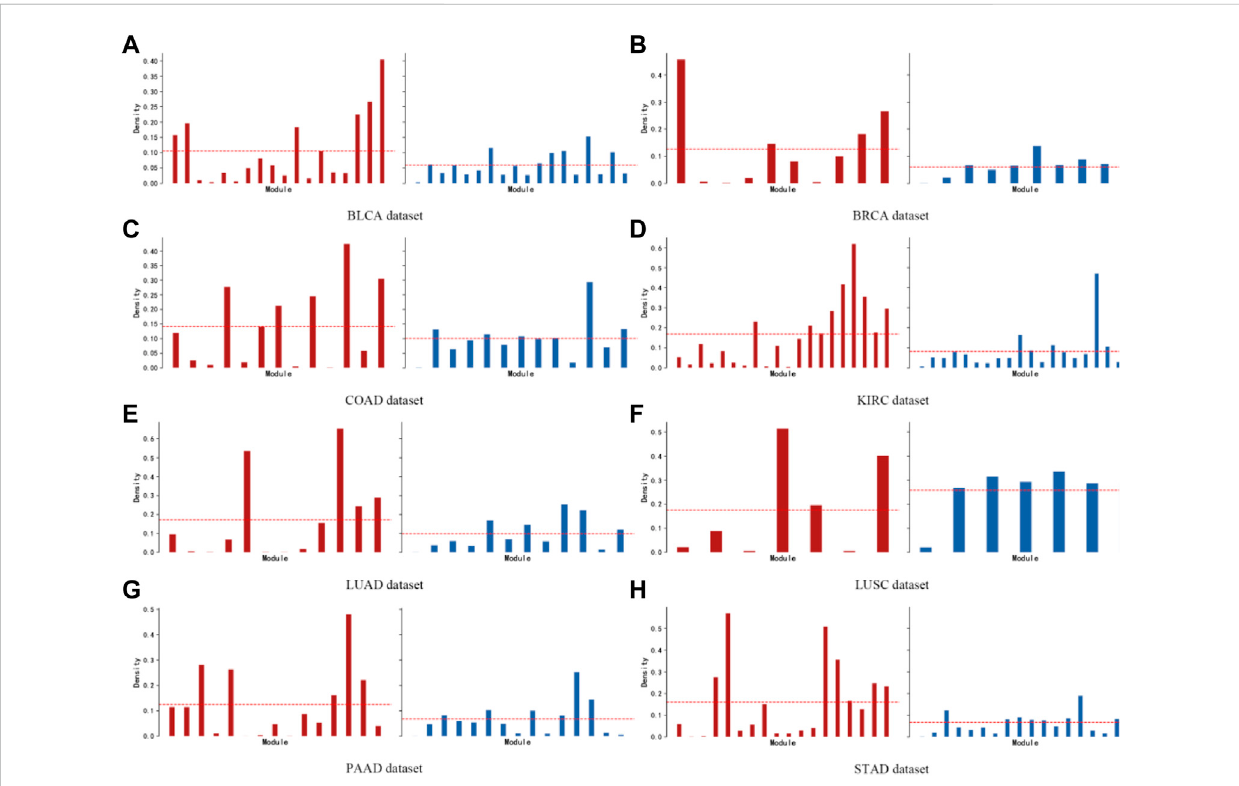
FIGURE 8 Moduledensity.Thebrownbarplotindicatesthemoduledensityobtained bytheKISLalgorithmoneachdataset, andthebluebarplotindicatesthe results of the widely used method WGCNA. Our method obtains a larger average module density on seven of the datasets and has a larger number of modules with a larger density. In addition, the top 3 modules with the highest module density on all eight datasets are obtained by our algorithm.